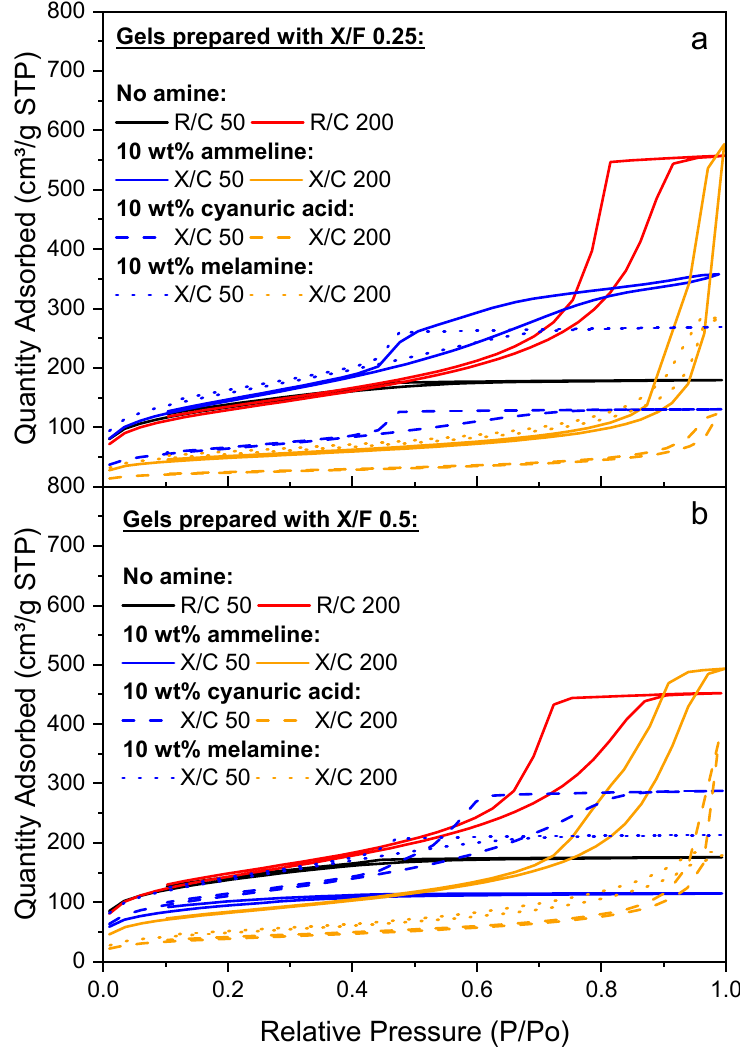
Figure 5. Nitrogen sorption isotherms for gels prepared with 10 wt% of additives and with ( a ) X/F 0.25 and ( b ) X/F 0.5.